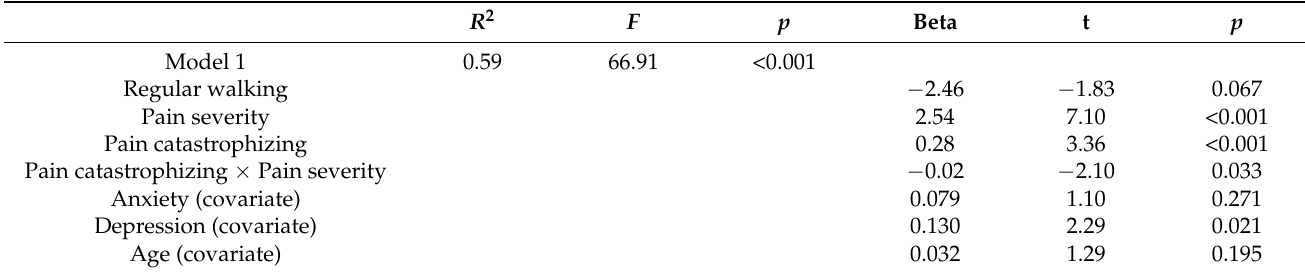
Table 2. Moderate mediation analysis assuming pain catastrophizing as mediator (outcome variable = functional limitation).